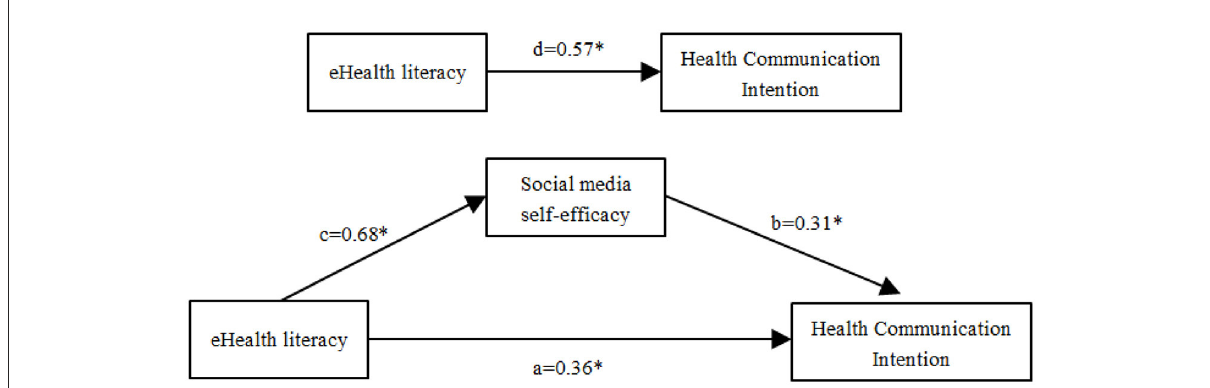
FIGURE2 Mediation model shows the direct effect and path coefficients that link eHealth literacy and health communication intention via social media self-efficacy ( n = 958). a: the unstandardized regression coefficient between eHealth literacy on health communication intention. b: the unstandardized regression coefficient between social media self-efficacy and health communication intention; c: the unstandardized regression coefficient of eHealth literacy on social media self-efficacy; d: the total effect between eHealth literacy and health communication intention. * : p ≤ 0.001.